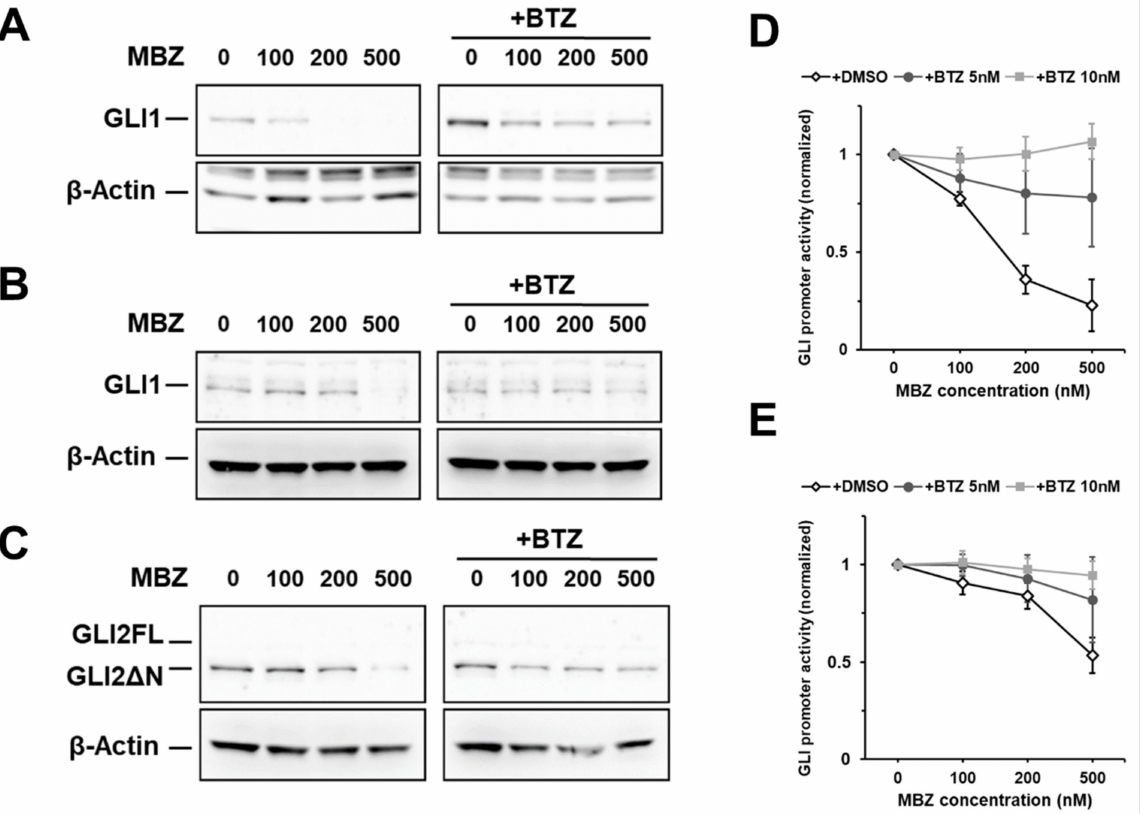
Figure 2. Decreased GLI1 and GLI2FL/GLI2 ∆ N protein levels upon MBZ treatment. Cell lines THP-1 ( A ) and OCI-AML3 ( B , C ) were treated with the indicated concentrations of MBZ alone or in combination with 10 nM BTZ for 24 h. GLI1 ( A , B ) and GLI2 ( C ) protein expression was examined by western blot analysis. THP-1 ( D ) and OCI-AML3 ( E ) GLI luciferase reporter cells were treated with MBZ alone or in combination with 5 nM or 10 nM BTZ. The GLI promoter activity was measured after 24 h. Error bars represent the mean values ± standard deviation from at least three independent